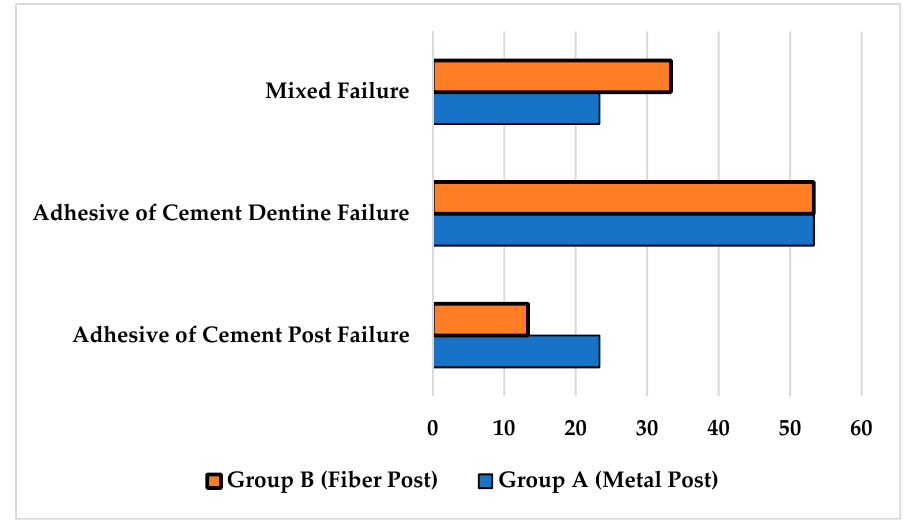
Figure 7. Graph showing analysis of failure modes for tested groups.